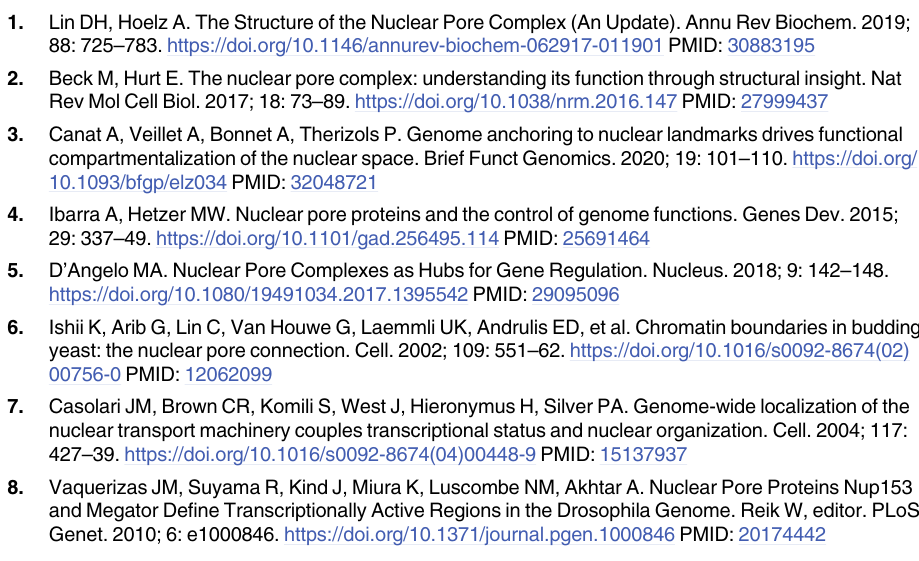
S4 Table. Primers used in this